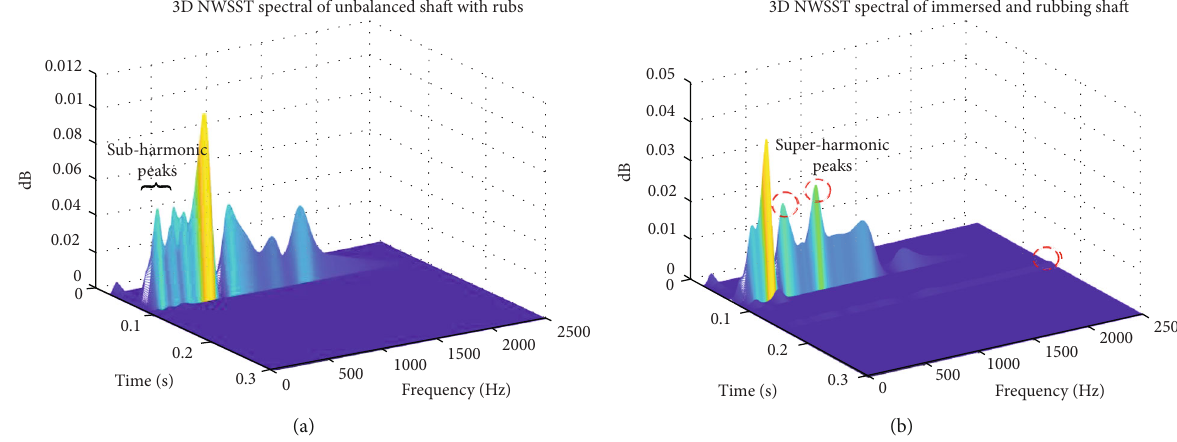
Figure 13: Experimental 3D Synchrosqueezing Spectrum results of the system (a) in air and (b) fl uid